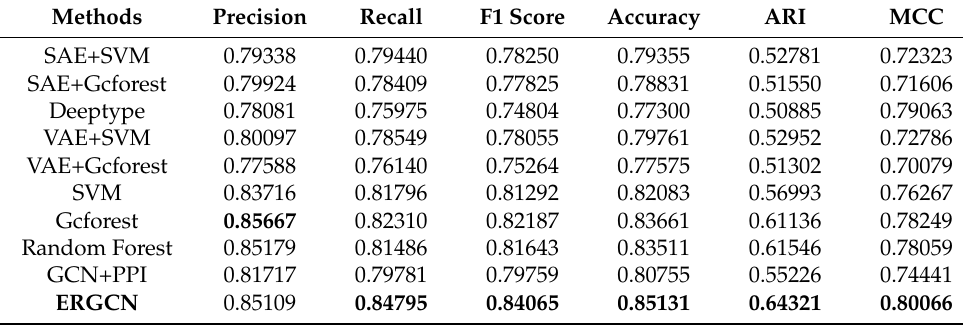
Table 2. The external evaluation metrics of every model on GBM dataset.